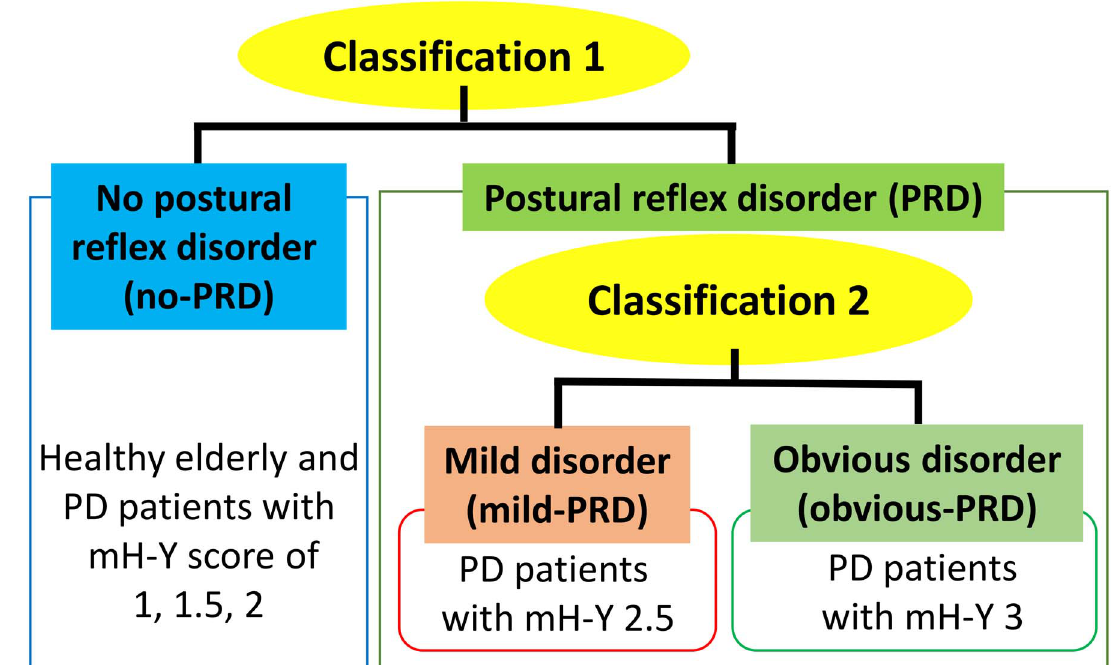
Figure 1. Classification of the severity of postural reflex disorder (PRD). doi:10.1371/journal.pone.0112952.g001 PLOS ONE |